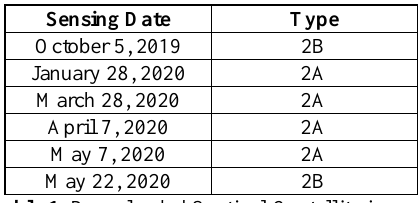
algorithm. The classification results are limited to qualitative